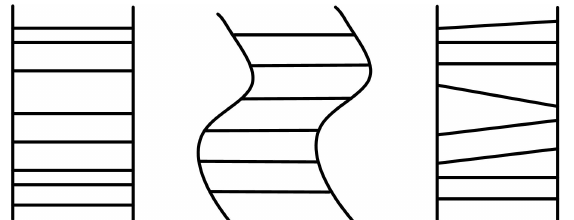
Figure 1 . The impact of satellite jitter on image geometry: pitch (left), roll (centre) and yaw (right) (Toutin et al ., 2011). In order to ensure the quality and availability of high-resolution remote sensing images, as well as to promote the application of obtainable satellite data, there have been many researches about jitter compensation. The approaches using multispectral images outperforms others due to their economical and convenient advantages (Iwasaki, 2011; Liu et al ., 2016). Multispectral bands with fixed row spacing are generally produced by the multispectral camera, and visible bands are better suited for jitter extraction with considering the similarity of them. By using only visible bands, Pan et al. (2021) reduced the coupled distortion and blur effects caused by satellite jitter simultaneously, which is the first research not considering geometric and radiometric information separately. However, as they indicate, the subpixel matching based on the correlation coefficient and least squares algorithm may limit the accuracy of jitter detection and then spread the detection error to image restoration. Hence, the impact of imaging matching methods on jitter compensation results is worthy of